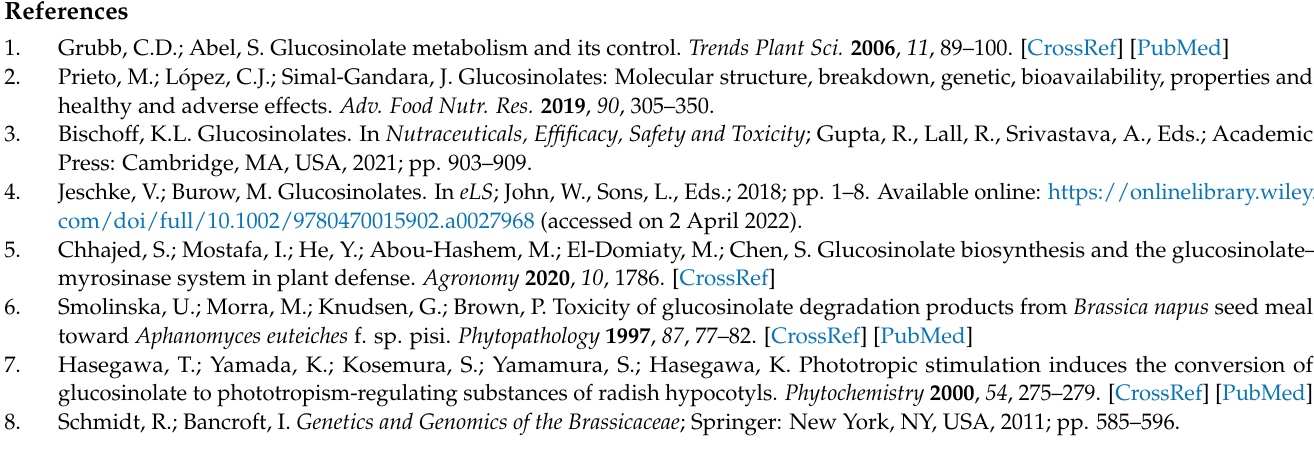
metabolites; Figure S2: Manhattan plots of association analysis for six glucosinolates using Q+K model; Figure S3: The significant SNPs associated with 6 glucosinolates in different environments; Figure S4: Correlation analysis of six glucosinolate metabolites in 2017cq and 2018cq; Table S1: Summary of repeatedly detected SNPs for 6 glucosinolate metabolites by mGWAS; Table S2: Summary of interval regions for 6 glucosinolate metabolites in B. napus ; Table S3: Candidate interval regions for 6 glucosinolate metabolites in B. napus ; Table S4: Candidate genes for 6 glucosinolate metabolites in B. napus ; Table S5: The expression levels of the candidate genes in BnHG and BnLG of B. napus ; Table S6: The list of 143 B . napus accessions used in this study; Table S7: Statistical analysis of 6 glucosinolate metabolites in high-, medium- and low-glucosinolate-content